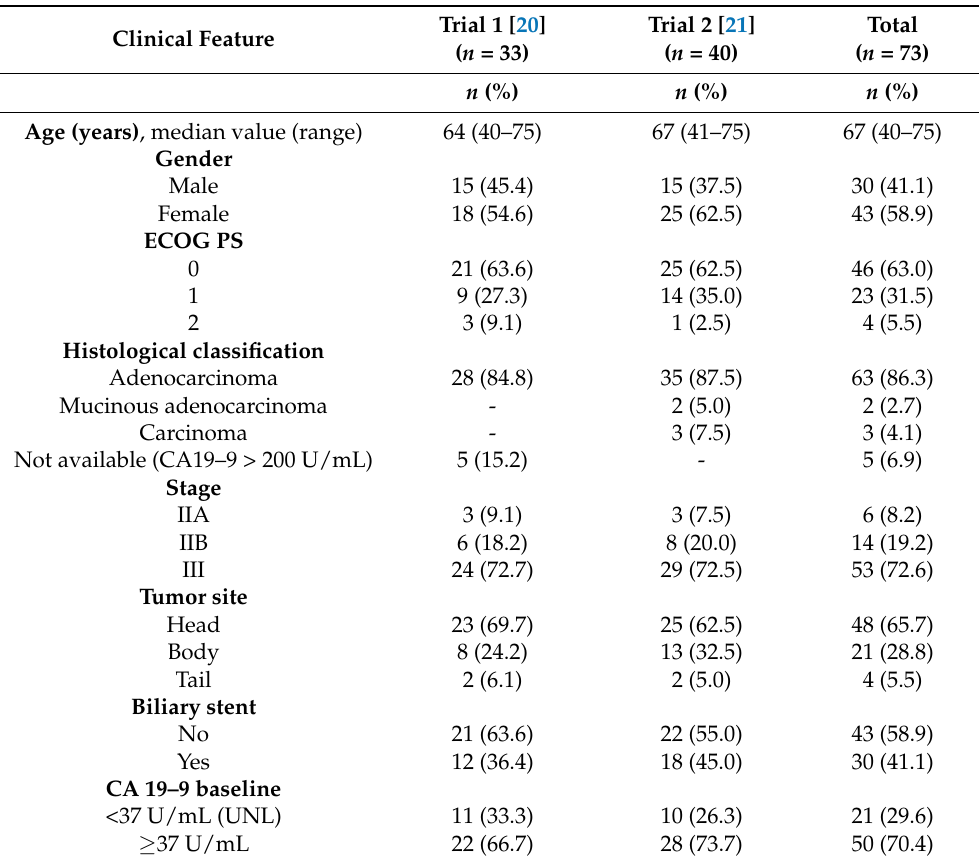
Table 1. Patient